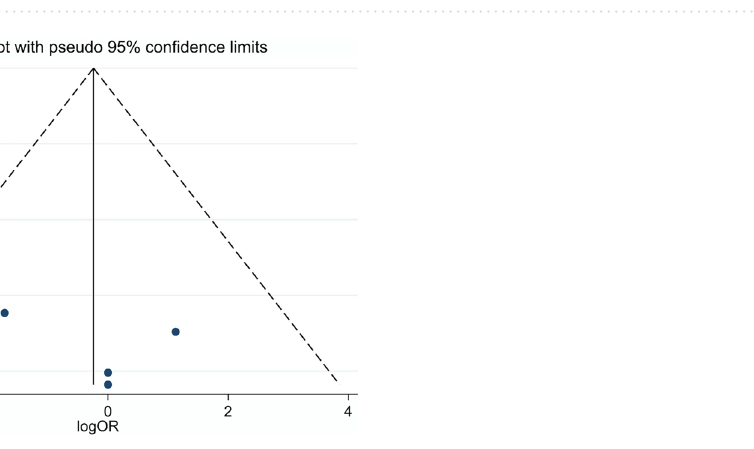
Figure 2. Forest plot of studies measuring clinical success of different treatment modalities of OSSN. The clinical success of each study and the 95% confidence intervals (CIs) are presented. The diamond at the bottom represents the overall clinical success for all studies.